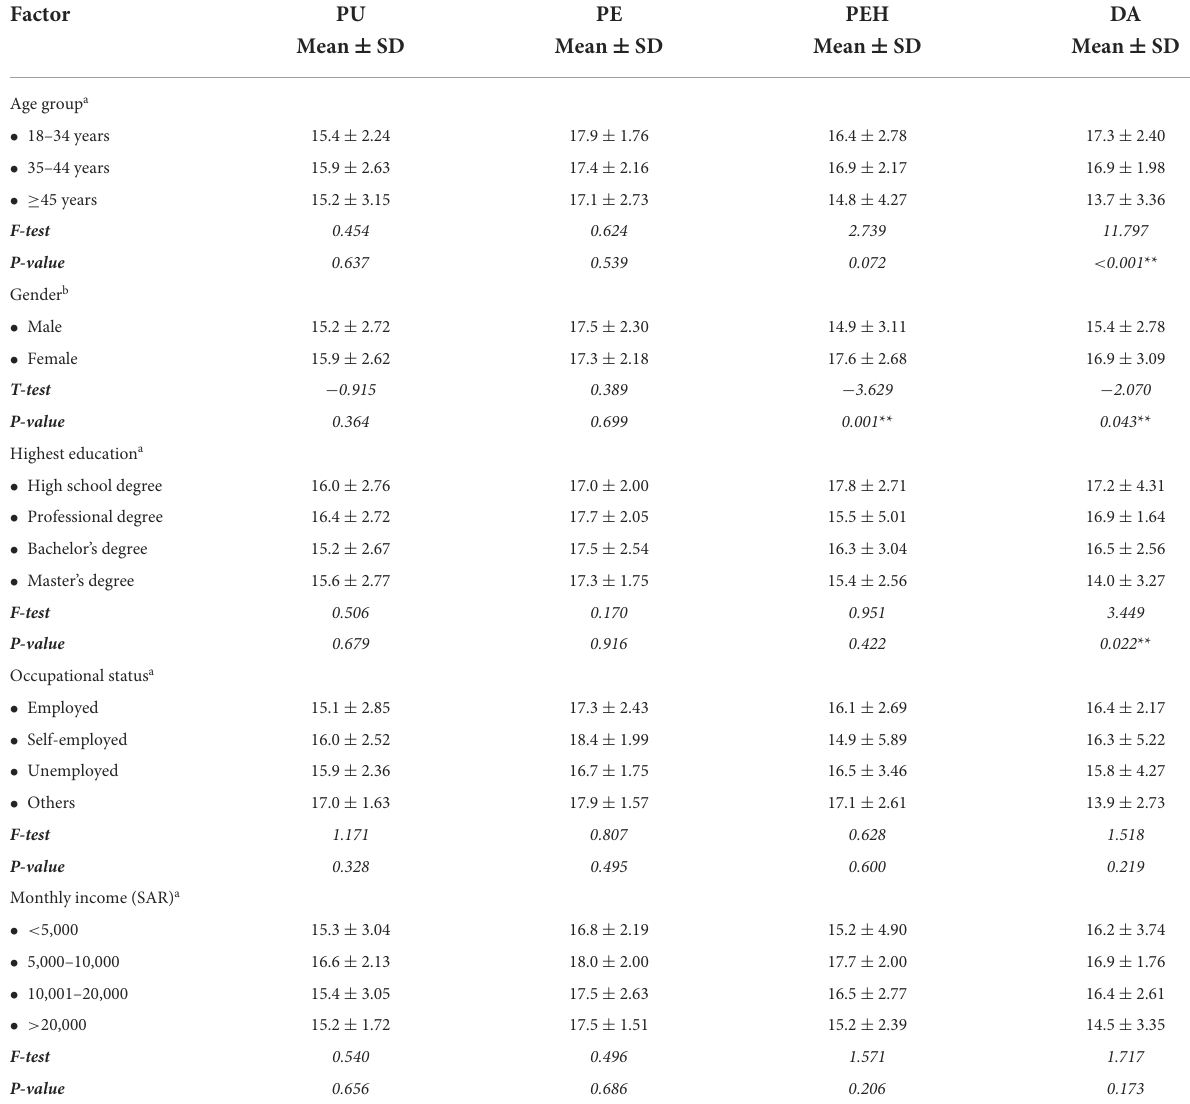
TABLE 5 Comparison between design aesthetic, perceived usefulness, ease of use, enjoyment and healthology in relation to the socio demographic characteristics of participants. Factor PU PE PEH DA Mean ± SD Mean ± SD Mean ± SD Mean ±